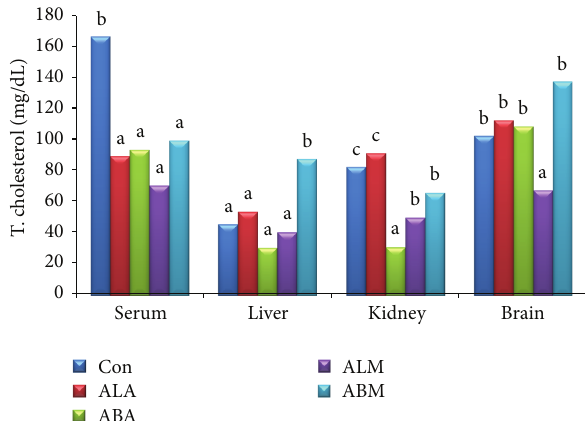
Figure 3: Total cholesterol content of control and extract treated groups (mg dL −1